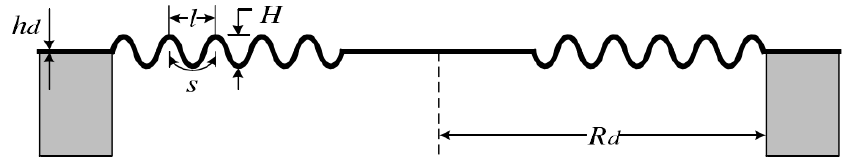
Figure 5. The schematic view of the shallow corrugated diaphragm (CD) .